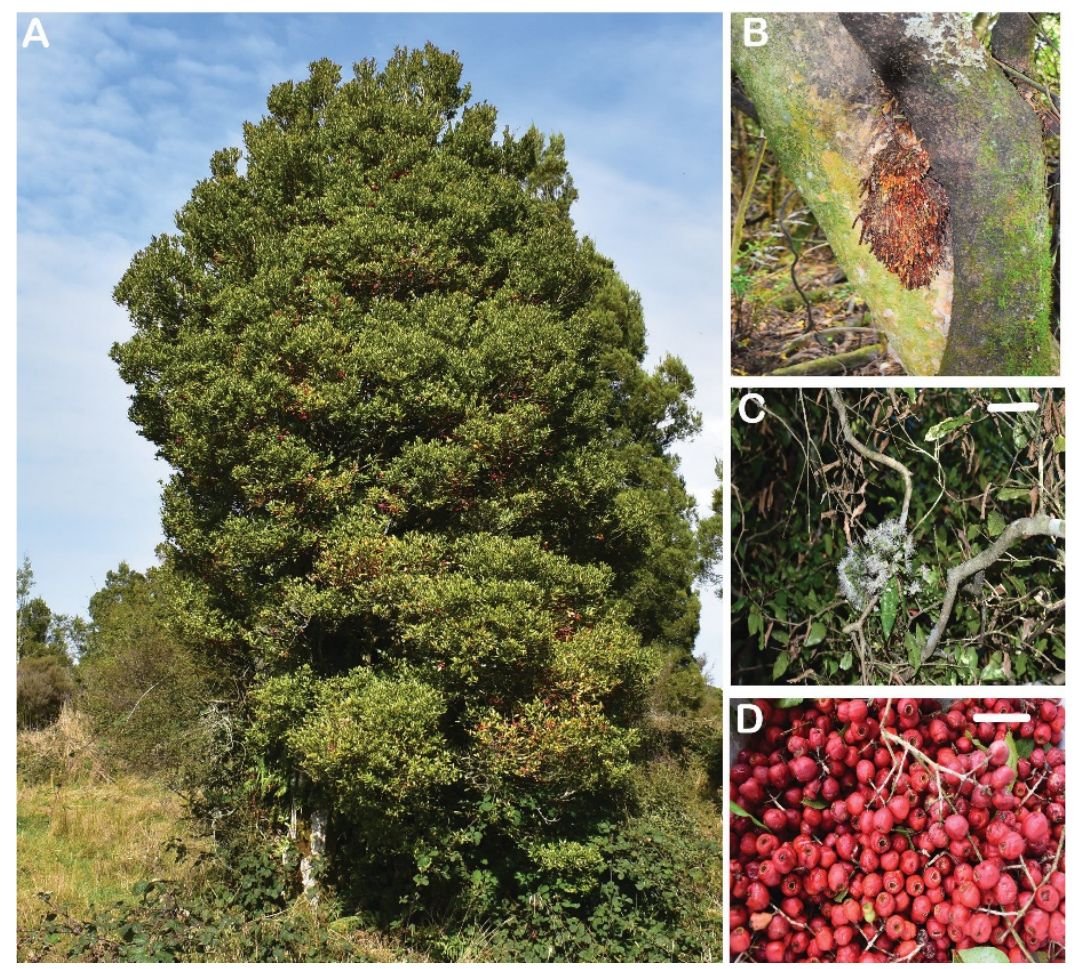
Figure 1. Syzygium maire in habitat ( A ) with pneumatophores on the main trunk ( B ). Creamy white flowers are present between February and April ( C ) with fruit development over 8–11 months, producing mature berries in autumn ( D ). Scale bar = 3 mm.